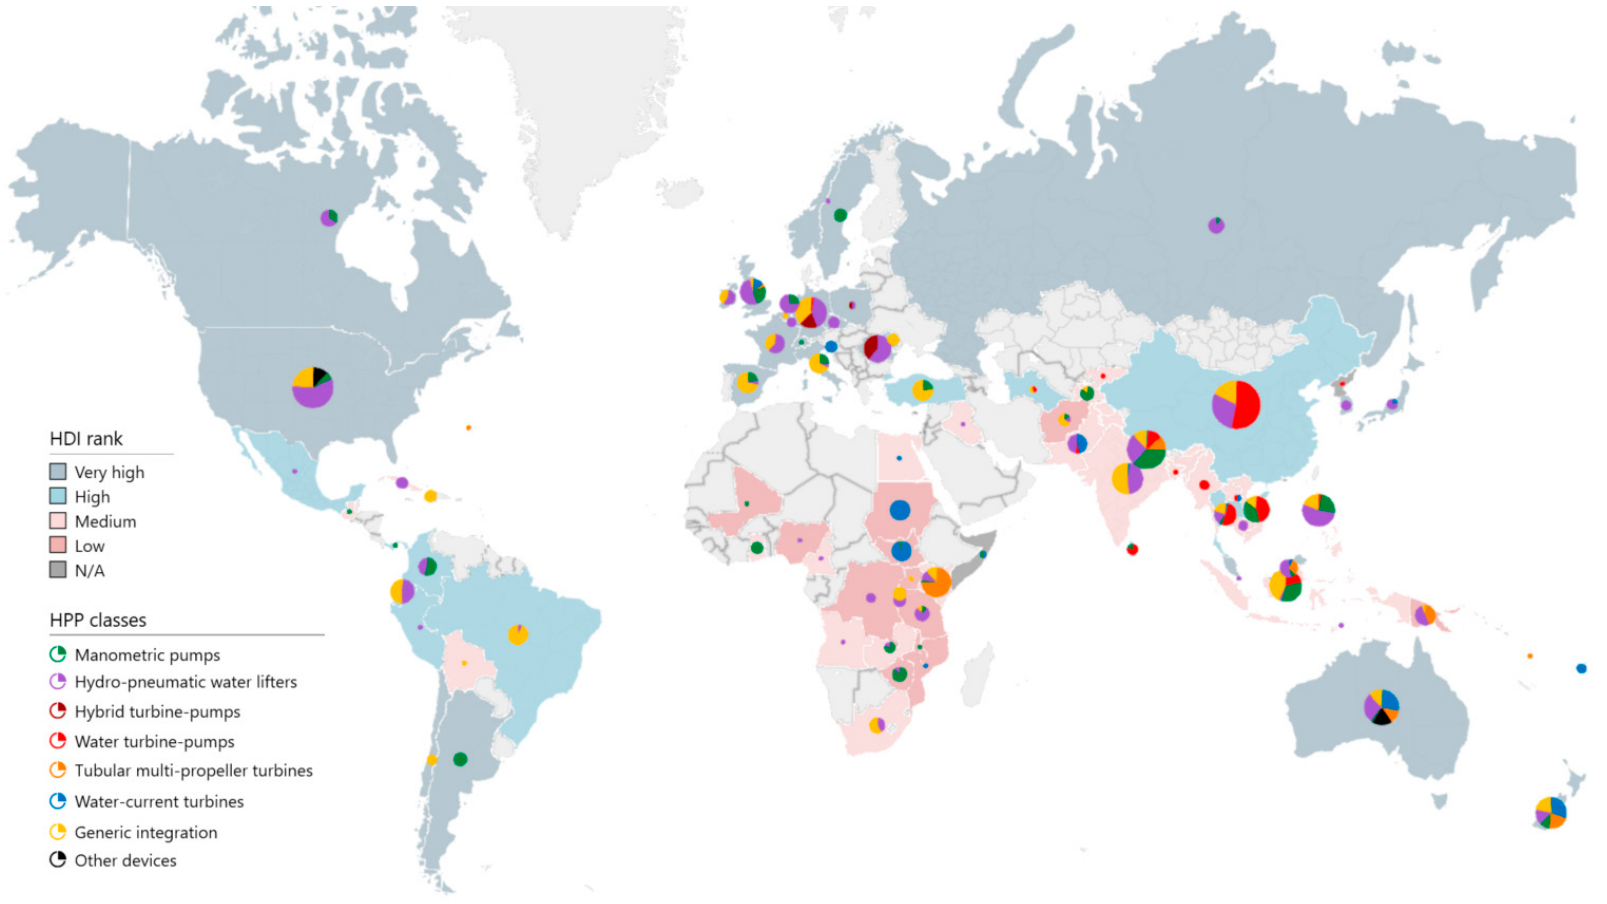
Figure 13. Worldwide mapping of HPP technologies per country. The size of each circle and the arc length of each colored slice represent, proportionally based on a logarithmic scale, the total number of reported devices and the number of reported devices per HPP classes, respectively. The background color of each country depicts its rank regarding the Human Development Index (HDI).